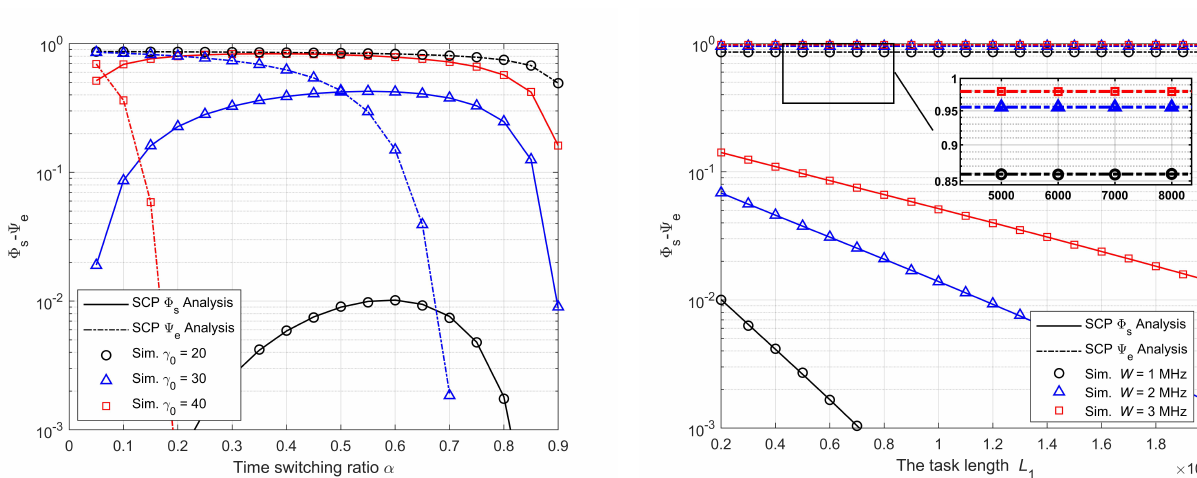
Figure 4. Impacts of the time switching ratio Figure 5. Impacts of the task length and the